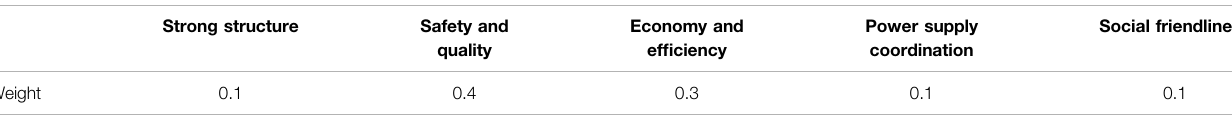
TABLE 3 | Setting of indicator